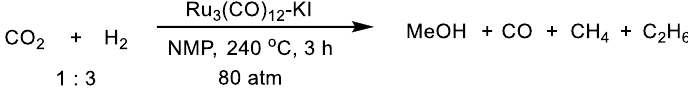
Figure 1. Hydrogenation of CO 2 using Ru 3 (CO) 12 .